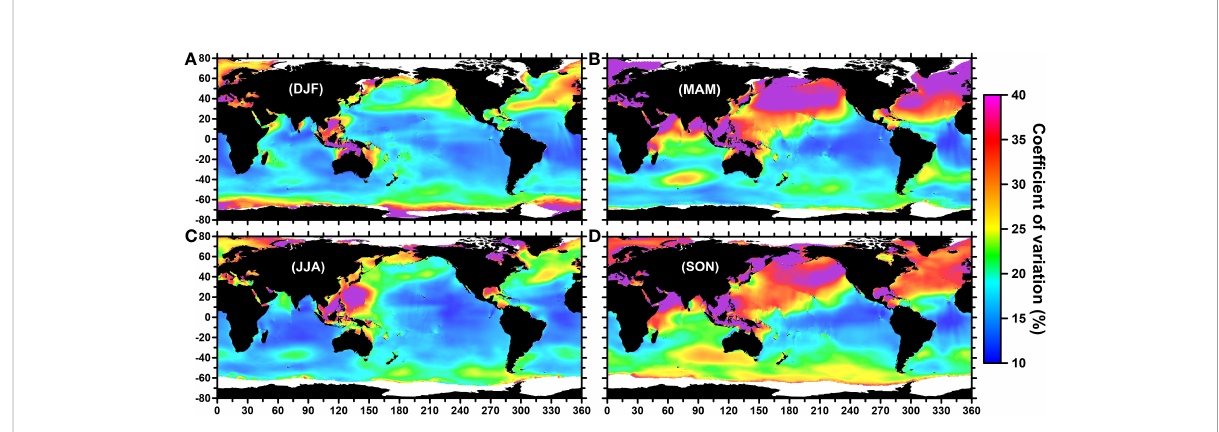
FIGURE 6 Coef fi cient of variation of seasonal wave power (seasons correspond to the Northern Hemisphere). (A) Winter (DJF: December, January, February), (B) spring (MAM: March, April, May), (C) summer (JJA: June, July, August), and (D) autumn (SON: September, October,